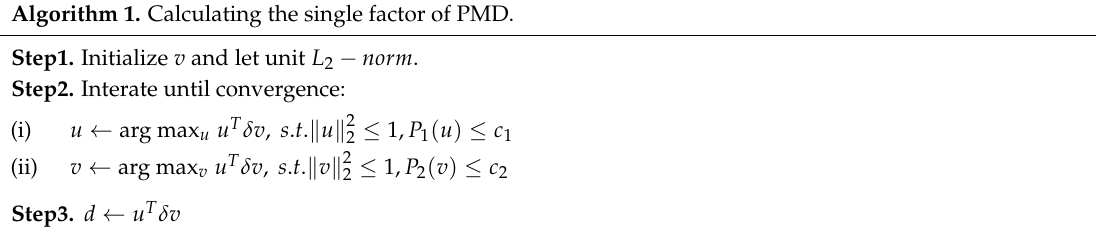
Algorithm 1. Calculating the single factor of PMD.